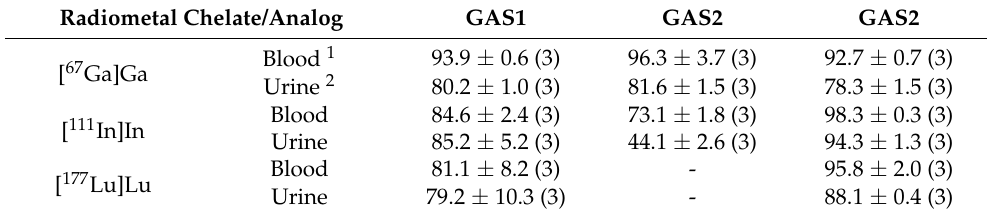
Table 2. In vivo degradation of radioligands in mice blood and urine. Radiometal Chelate/Analog